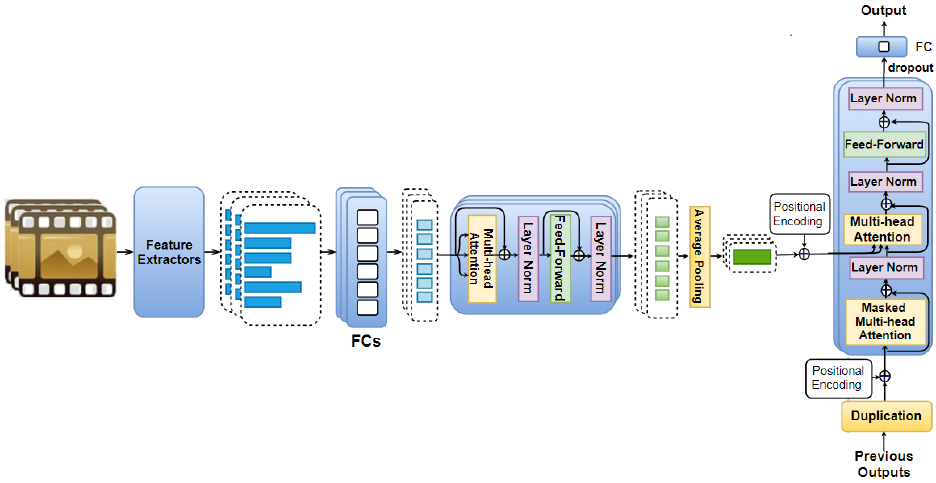
Figure 4. Our proposed Mixed AttendAffectNet: Feature vectors extracted from each movie part are first fed to fully connected layers for dimension reduction before being passed to N identical layers. Each of them includes a muli-head attention followed by a feed-forward layer. We apply average pooling to the outputs of those identical layers to obtain representation vectors corresponding to movie parts. We add positional encodings to these representation vectors, which are then fed to another set of N identical layers. These layers are similar to the previous ones, except that each of them includes one more layer called masked multi-head attention. This set of N identical layers is followed by dropout, and a fully connected layer. The previous outputs together with their corresponding positional encodings are used as the additional input to this